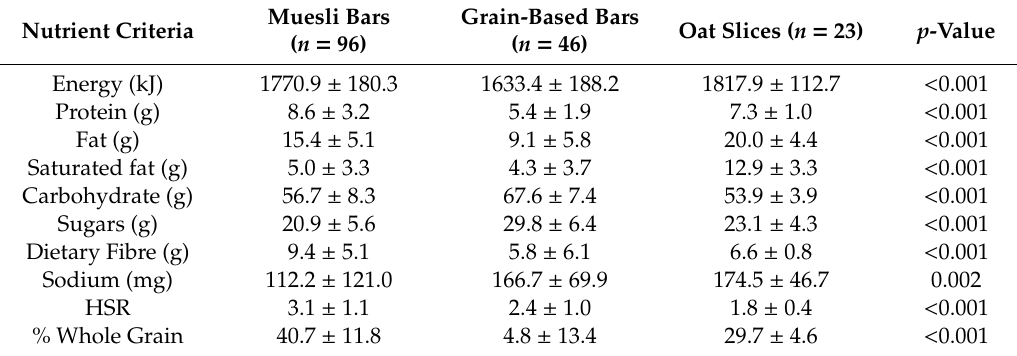
Table 3. Nutrients, whole grain, and HSR / 100 g (mean & SD) in muesli bars, grain-based bars, and oat